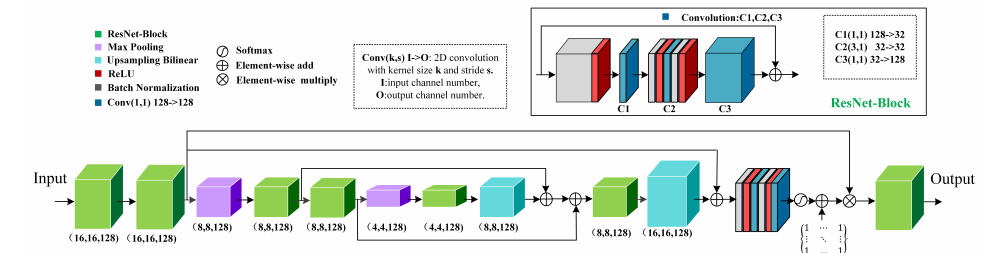
Figure 5. The architecture of our proposed attention